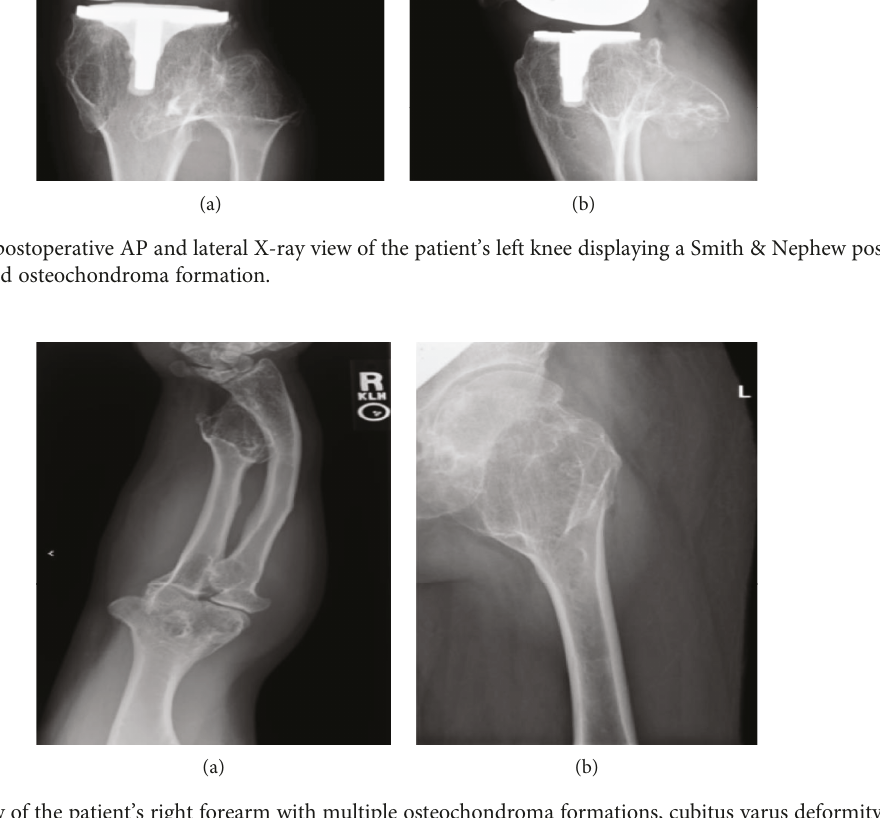
Figure 3: (a) An AP view of the patient ’ s right forearm with multiple osteochondroma formations, cubitus varus deformity, and shortened limb length. (b) An AP view of the patient ’ s left femur displaying a large femoral neck osteochondroma with deformity of trochanteric structures.